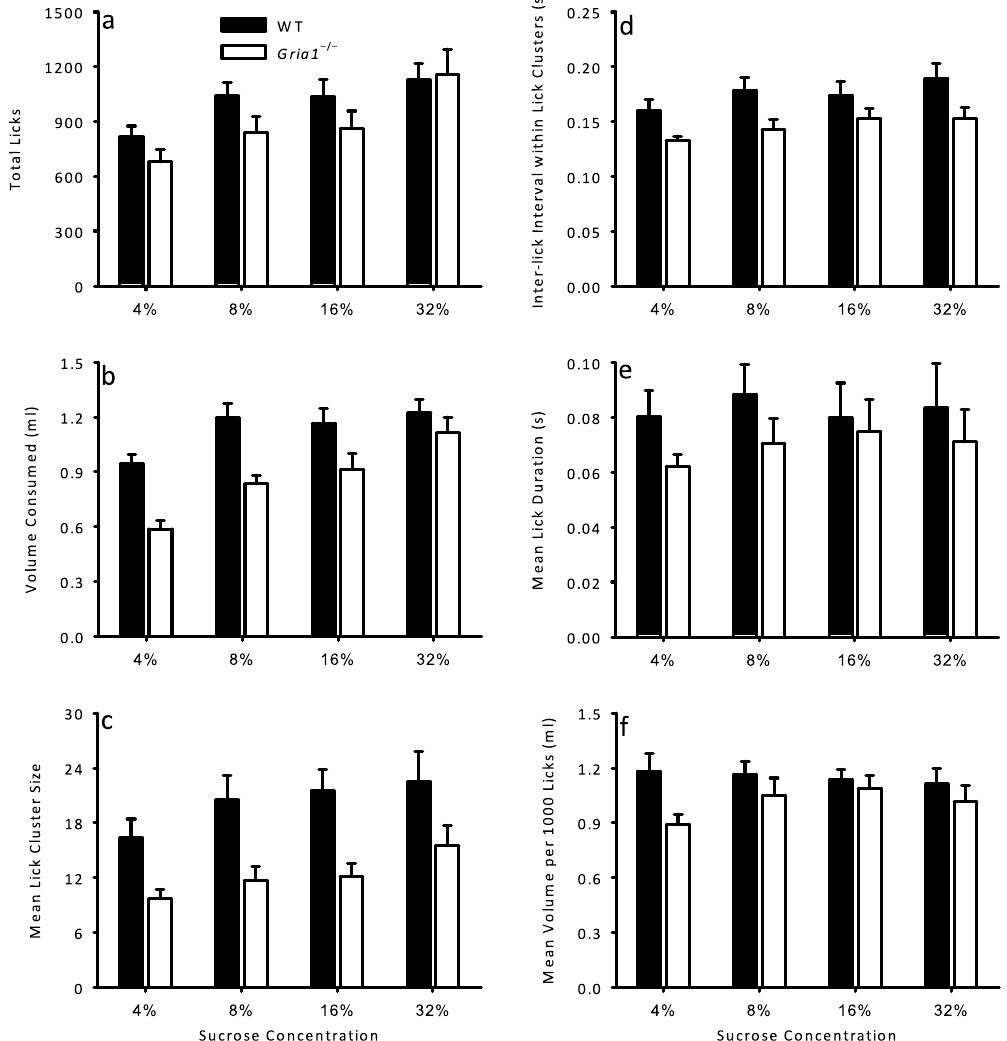
Figure 1. Licking behaviour as a function of sucrose concentration during a short, 10 minute access to sucrose in hungry mice. Six different measures of licking behaviour are given for WT (black bars) and Gria1 − / − (white bars) mice for consumption of 4%, 8%, 16%, and 32% sucrose solutions: ( a ) total licks; ( b ) volume consumed (ml); ( c ) mean lick cluster size; ( d ) inter-lick interval within lick clusters (s); ( e ) mean lick duration (s); ( f ) mean volume per 1000 licks (ml). Error bars indicate